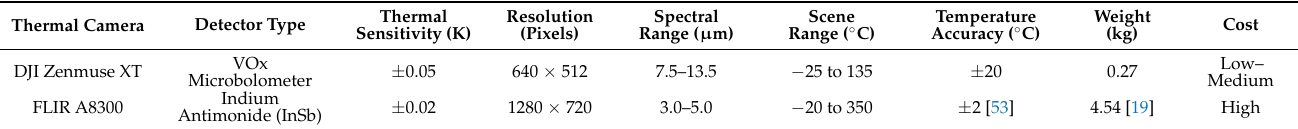
Table 1. Specification comparison between cooled and uncooled thermal